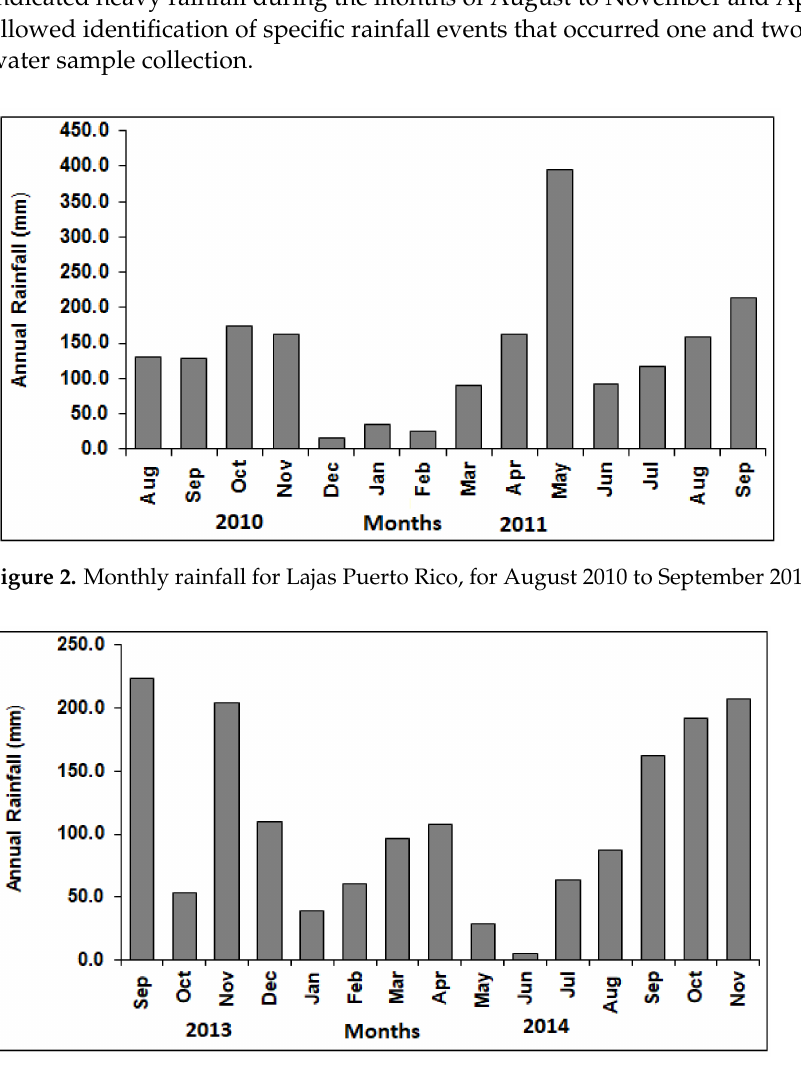
Figure 3. Monthly rainfall for Lajas Puerto Rico, for September 2013 to November